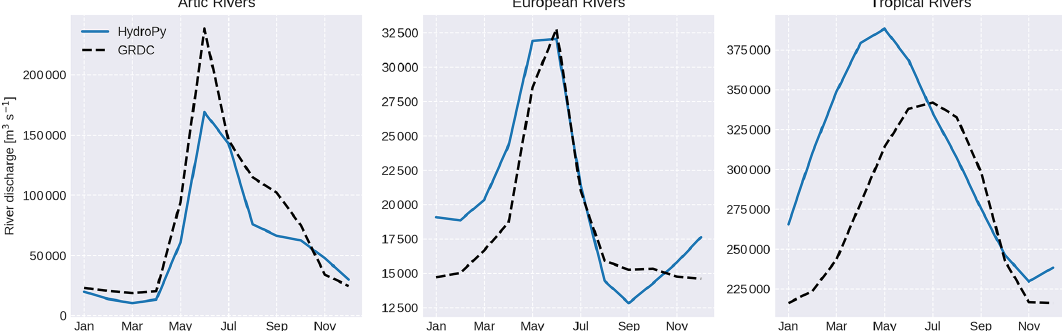
Figure 10. Climatological river discharge curves averaged for selected rivers in three regions: Arctic rivers (Lena, Ob, Yenisey, Amur, Kolyma, Mackenzie River and Yukon), European rivers (Danube, Rhine, Rhone, Po, Vistula, Pechora and Neva) and tropical rivers (Amazon, Congo, Orinoco, Mekong, Rio Magdalena, Zambezi and Niger). Simulated HydroPy discharge curves are indicated in blue, and GRDC observations are in dashed